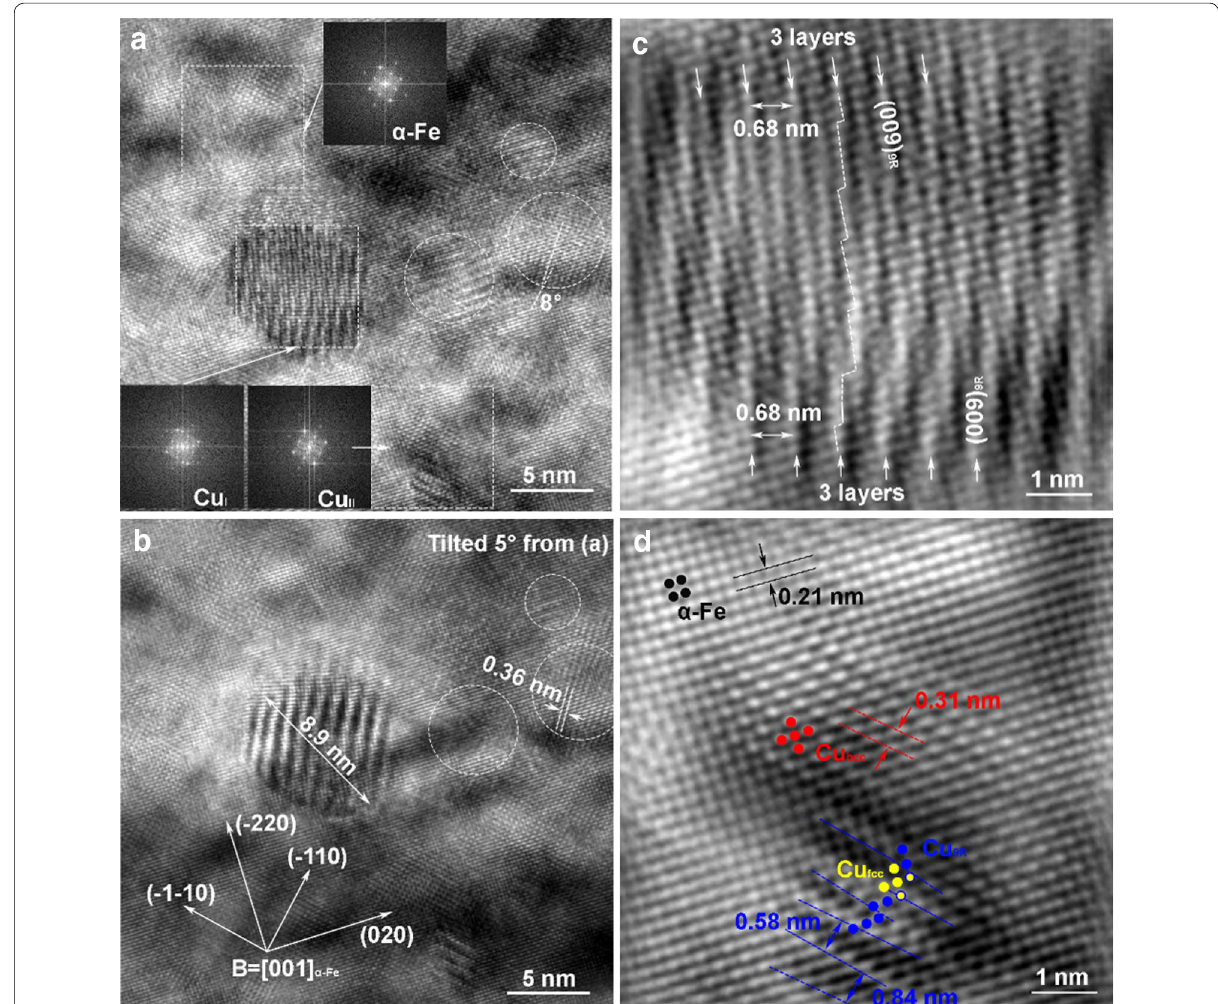
Figure 3 a HRTEM image of Cu precipitates formed in α-Fe matrix; b HRTEM image with 5o tilted from a ; c , d IFFT images of selected Cu I and Cu II in a , indicating the complex structure of Cu